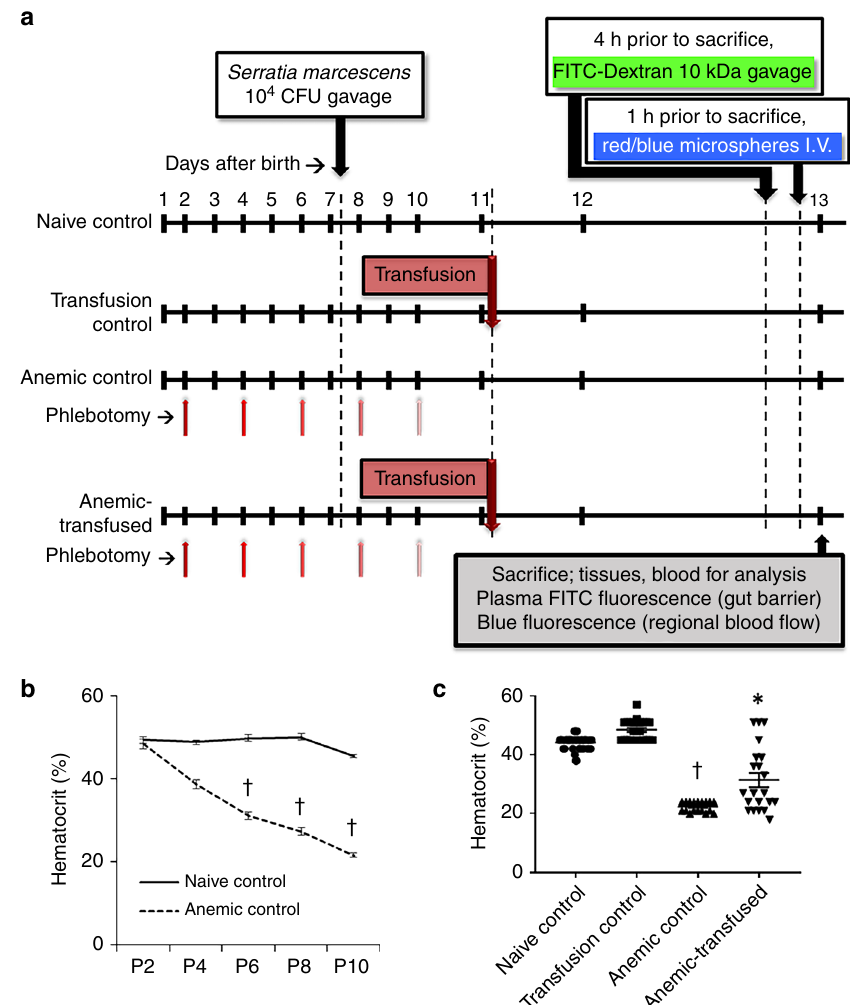
Fig. 1 Neonatal murine model of red blood cell (RBC) transfusion-associated necrotizing enterocolitis (NEC)-like injury. a Schematic shows the sequence of interventions in naive control, transfusion control, anemic control, and anemic-transfused mice. b Longitudinal change in hematocrit in mice subjected to repeated phlebotomy. Line diagrams (means ± standard error, SE) show serial hematocrits in control vs. anemic mice. c Hematocrit in the four study groups. Scatter column plots (means ± SE) show the hematocrit values on P12 (24 h after transfusions). Data in b , c represent N = 42 animals in naive control, 21 in transfusion control, 18 in anemic control, and 21 in anemic-transfused groups. Kruskal – Wallis H test with Dunn ’ s post test, * P < 0.05, † P < 0.001 vs. naive